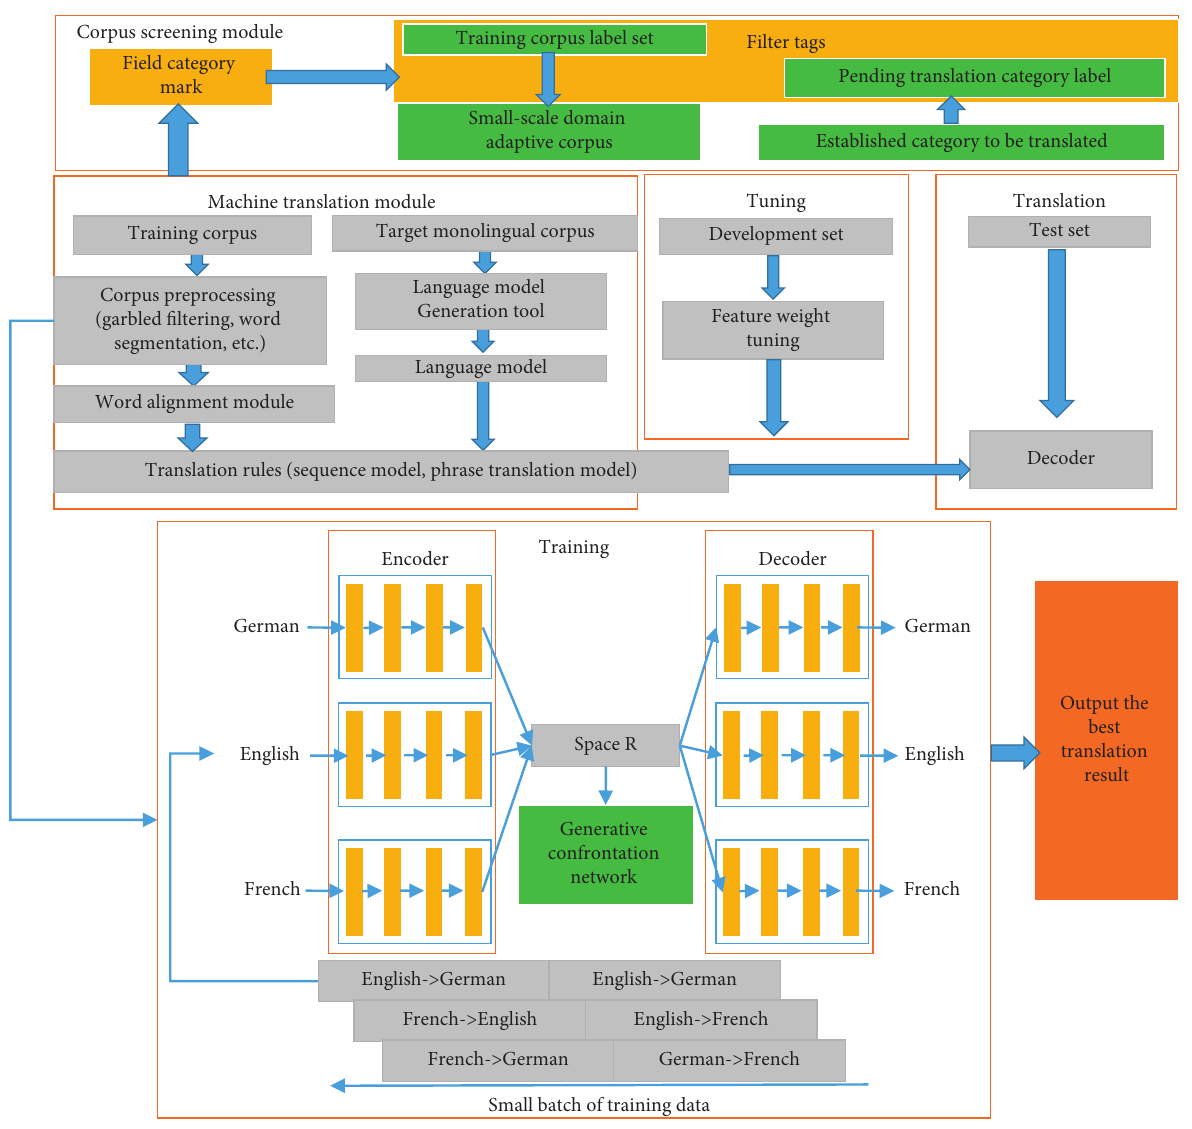
Figure 4: Flow chart of the machine translation algorithm in this